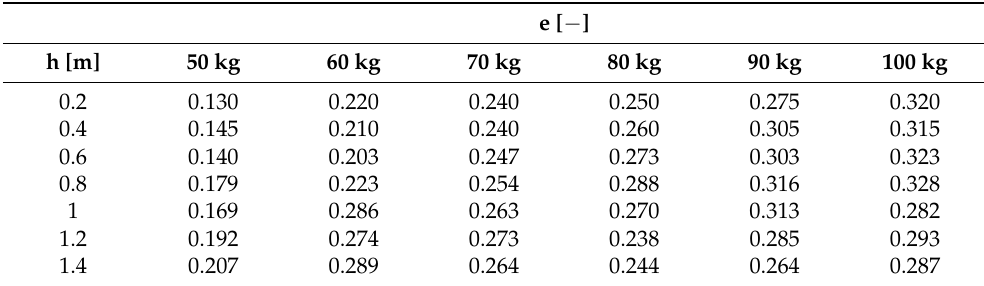
Table 3. Coefficient of restitution, e, of the rebounding process for the hammer with the pyramidal impactor for individual